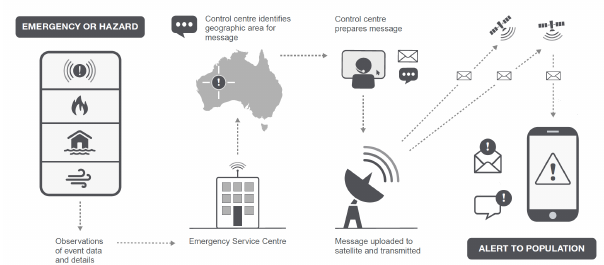
Figure 1. Basic concept of a GNSS EWS transmission